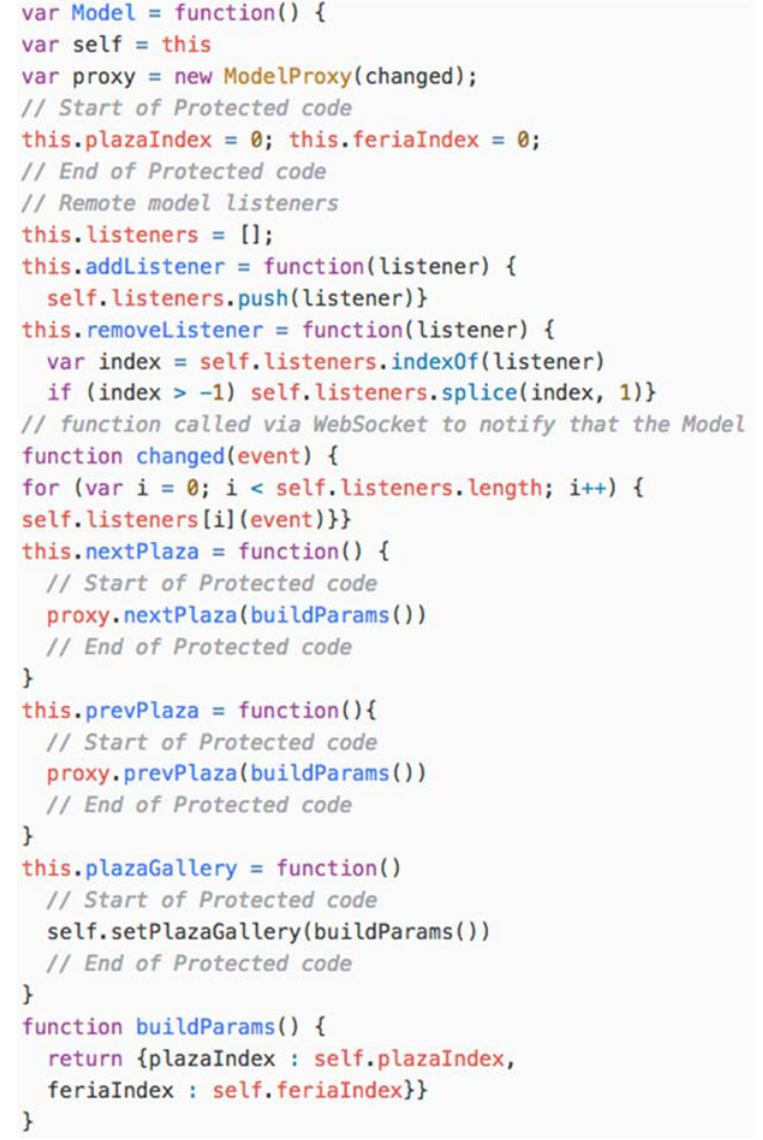
Figure 10. Fragment of code generated by the transformation for the remote model configuration.